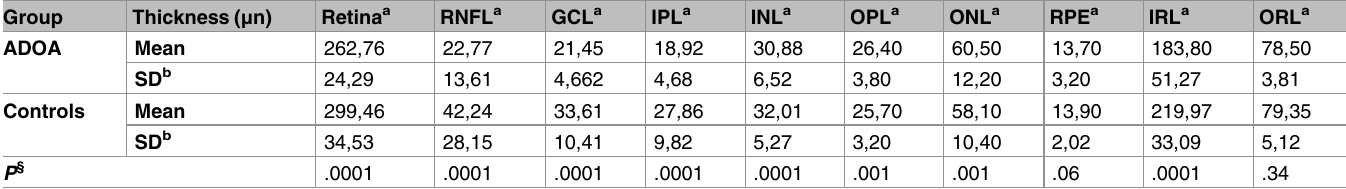
Table 2. Posterior Pole Retinal Layers Thickness values and Statistical Differencesbetween Patients with ADOA and controls.